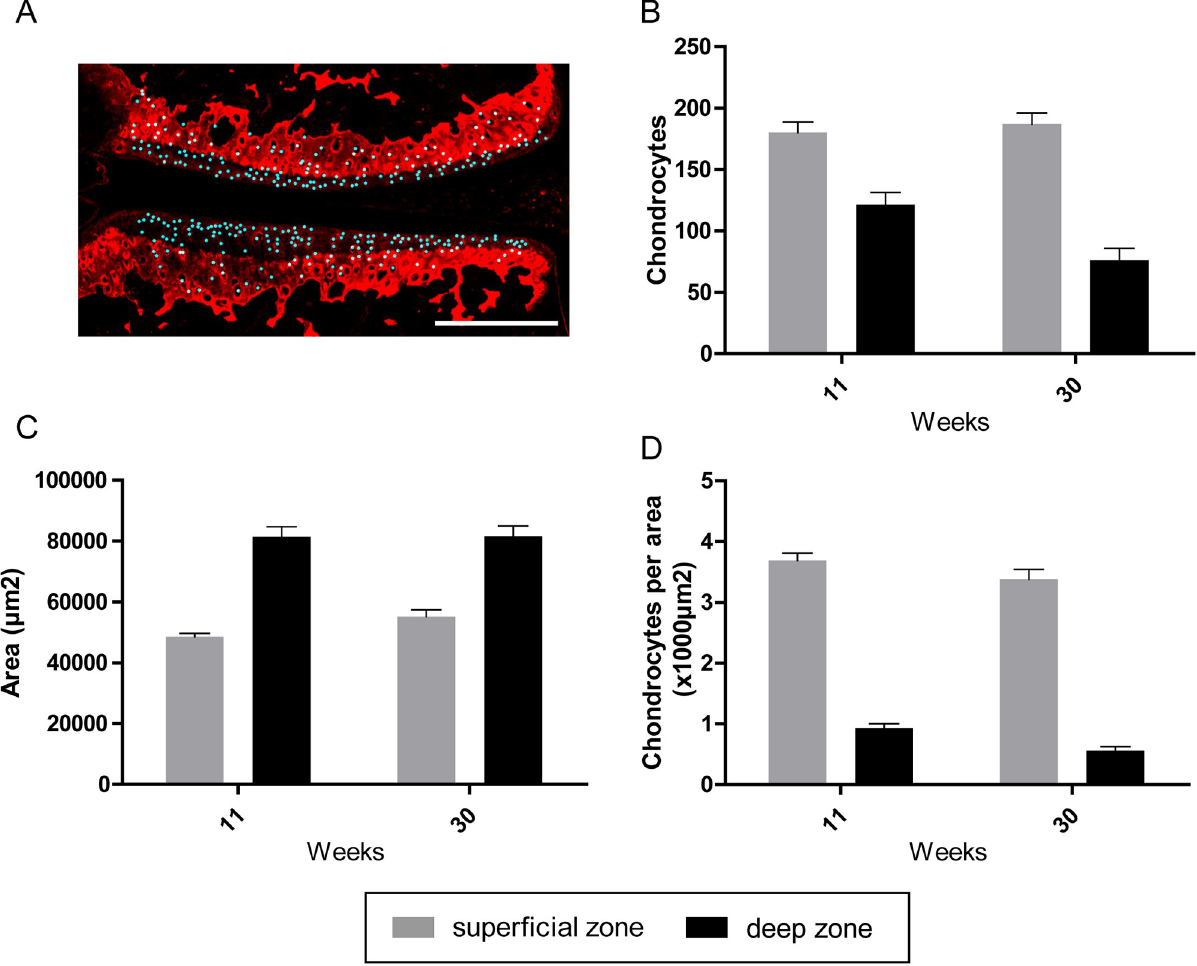
Fig 4. Automated detection and quantification of chondrocytes in naive mice of 11 and 30 weeks of age (A) . (B) Dynamics of chondrocyte numbers in the non-calcified zone and calcified zone. (C) Area of the non-calcified zone and calcified zone. (D) Chondrocyte numbers in the non- calcified zone and calcified zone. Data represent mean values ± SEM. Bar = 250 μ m.